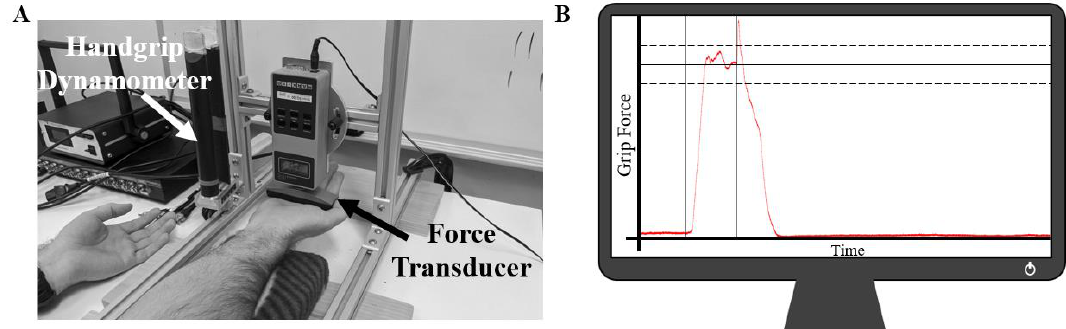
Figure 1. ( A ) Experimental setup for wrist flexion MVCs. In this photo, the force transducer is positioned above the palm and aligned along the distal portion of the metacarpal bones. The forearm could be pronated to perform wrist extension MVCs. The left (non-dominant arm) was rested upon the table, palm up, to prevent any assistance during MVC trials. The same setup was utilized for the fatigue-inducing trial where participants exerted a sustained MVC until they reached the 25% cut-off. The handgrip dynamometer is also shown attached to the aluminum framing in close proximity to the force transducer. ( B ) Example of handgrip force displayed to participants. The solid horizontal line represented 10% of the individual’s maximal handgrip force, while the top and lower dashed lines represented 11 and 9%, respectively. Participants were instructed to begin gripping when the trace reached the first vertical line and would be stimulated 1.5 s later at the second vertical line.